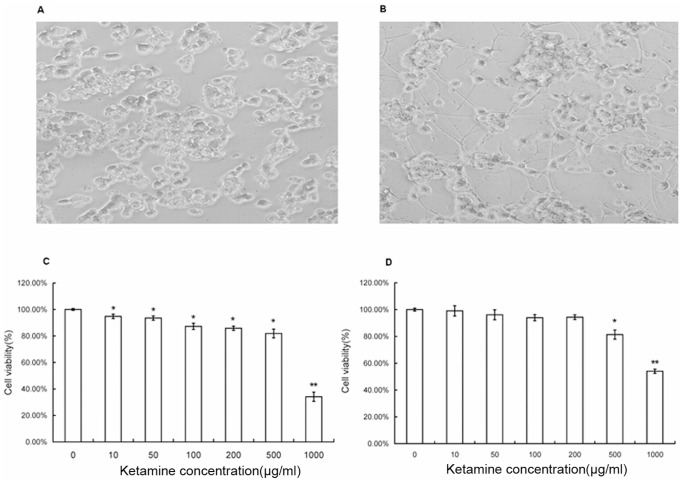
Cell viability of pheochromocytoma 12 (PC12) and differentiated PC12 cells following 24 hours ketamine treatment.A) Phase contrast image of undifferentiated PC12 cells. B) Phase contrast image of PC12 cells differentiated with nerve growth factor (NGF) (50 ng/ml) for 6 days. C) Dosage effects of ketamine on cell viability in undifferentiated PC12 cells. D) Dosage effects of ketamine on cell viability in differentiated PC12 cells. Data are presented as Mean± S.E.M. * p<0.05 as compared with control; **p<0.005 as compared with control.